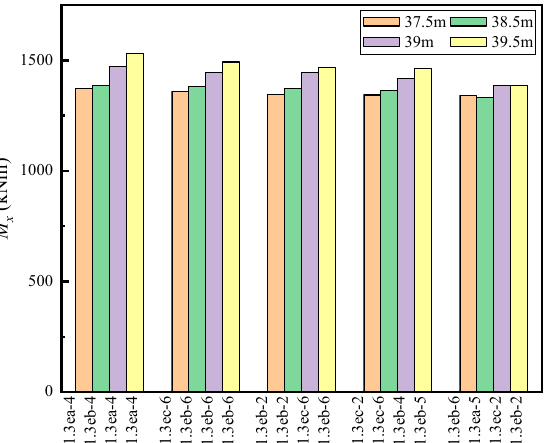
Figure 12. Histogram of M x at hub. (The label of the load case: the first letter refers to wind speed and “e” for 25 m/s; the second letter refers to yaw error, “a” for − 8 deg, “b” for 0 deg and “c” for 8 deg; the last number refers to the random seed number).